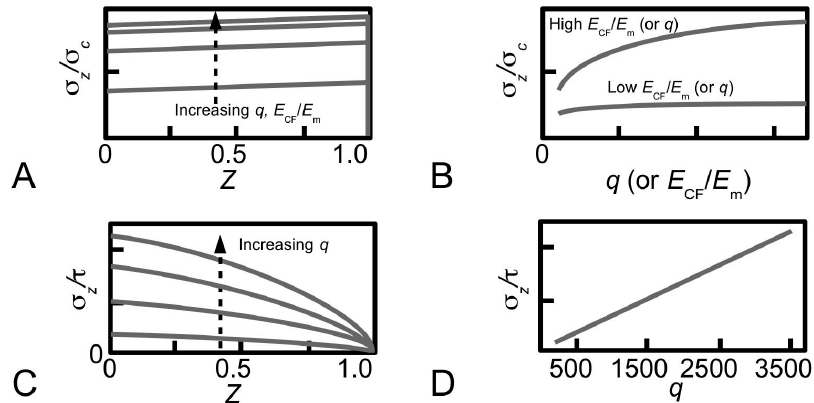
Figure 12. Effects of fibril aspect ratio, q , and ratio of moduli of the fibril to the interfibrillar matrix, E CF / E m , on the axial stress, σ z , in a fibril. Sketches of the ( A ) graph of normalized axial stress, σ z / σ c , versus fraction distance, Z , along the fibril and the associated ( B ) graph of σ z / σ c at the fibril centre ( Z = 0) versus q (or E CF / E m ) during elastic stress transfer [81]. Graphs of the ( C ) normalized axial stress, σ z / τ , versus Z along the fibril and the associated ( D ) graph of maximum σ z / τ (at Z = 0) versus q during plastic stress transfer; the results are obtained by evaluating the stress equation derived for the fibre with paraboloidal ends [107]. Thus, all results shown here apply to the fibril with a paraboloidal shape. The q values range 200 to 3500 (the arrow in part ( A , C ) indicates increasing q value). Of note, the authors of the paper describing these computer models have made clear the difficulties in meshing the model beyond an aspect ratio of 3500 and have defined a strategy that limits the analysis to within the constraints of the models; further details can be found in the reference [81]. Symbol σ c represents the applied stress acting on the tissue in the direction of the fibril and τ represents the fibril-matrix interfacial shear stress.